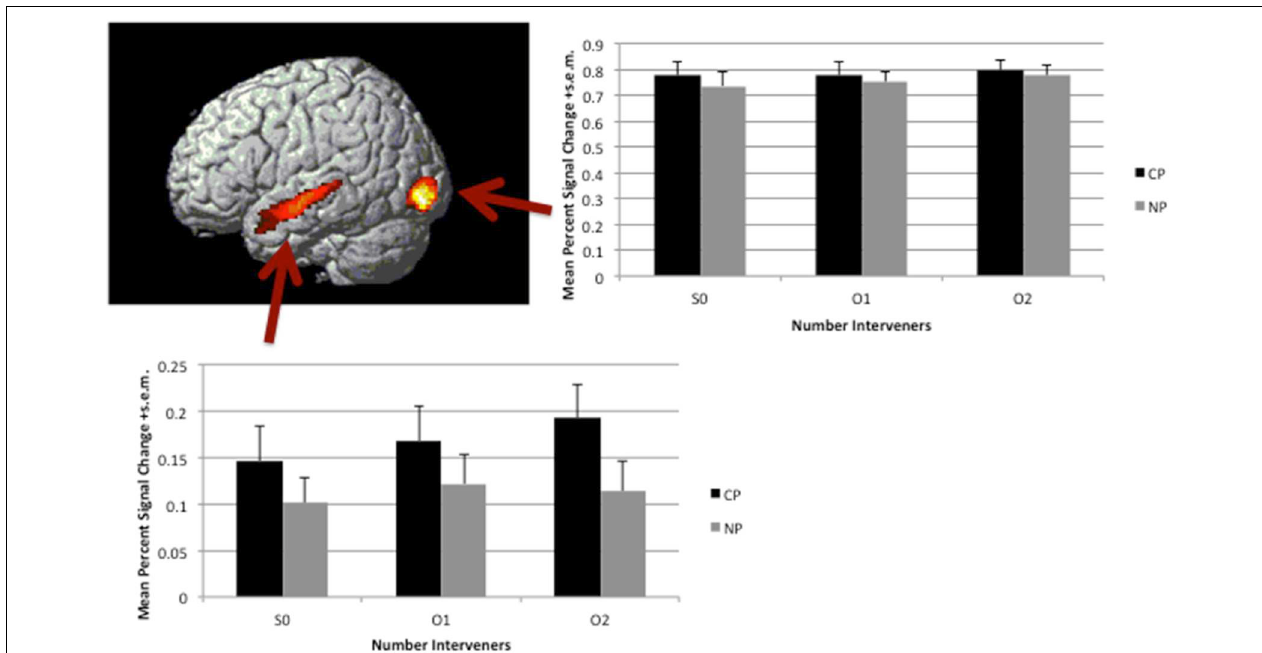
FIGURE 6 | Main effect of Type (CP > NP). Map is thresholded at voxel-wise p < 0 . 005 and corrected for multiple comparison through cluster size p < 0 . 05 . Activation is overlaid on a rendered surface of the brain. The histogram to the right presents the mean percent signal change +s.e.m. over the entire Inferior Occipital Gyrus cluster broken